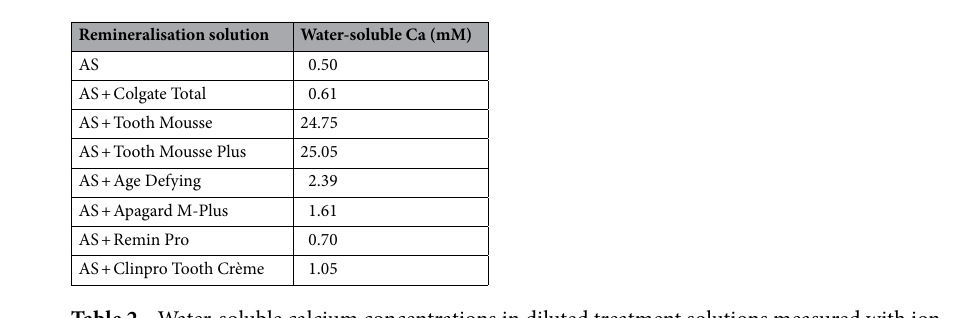
Table 2. Water-soluble calcium concentrations in diluted treatment solutions measured with ion